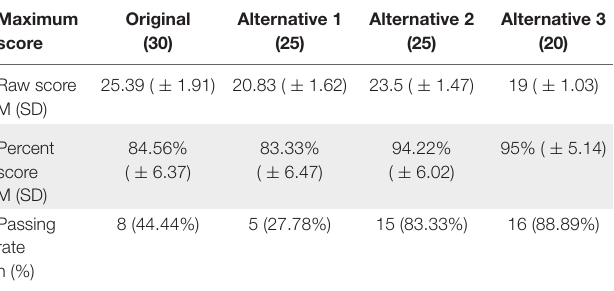
TABLE 5 | MoCA participant scores across the different scoring